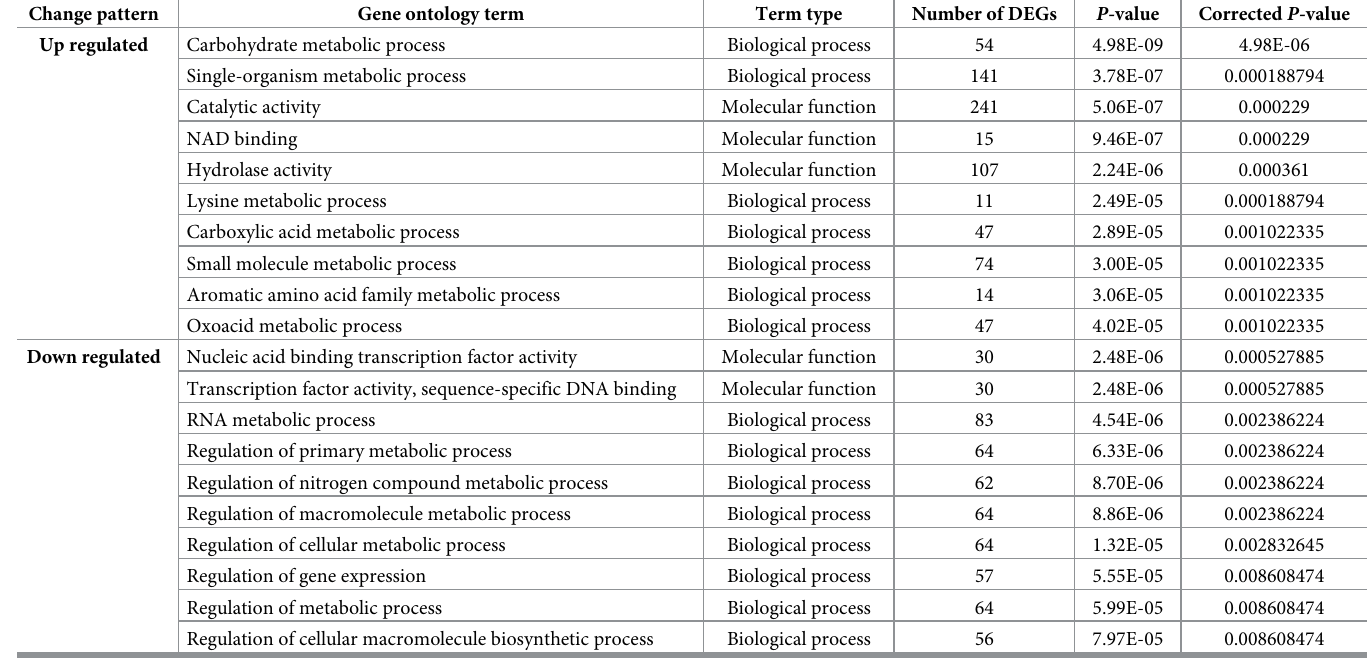
Table 2. Changes identified by GO analysis during T2 to